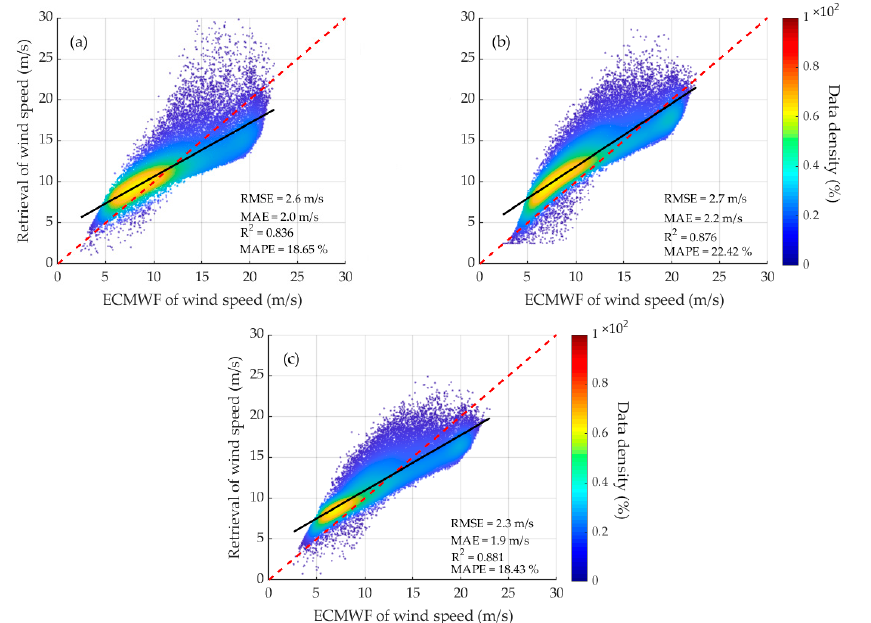
Figure 13. Scatter plot for estimated wind speed versus ECMWF wind speed derived from NBRCS with three models. ( a ), ( b ), and ( c ) correspond to Model-1, Model-2, and Model-3, respectively. Colors (from cold to warm) represent data density. to warm) represent data